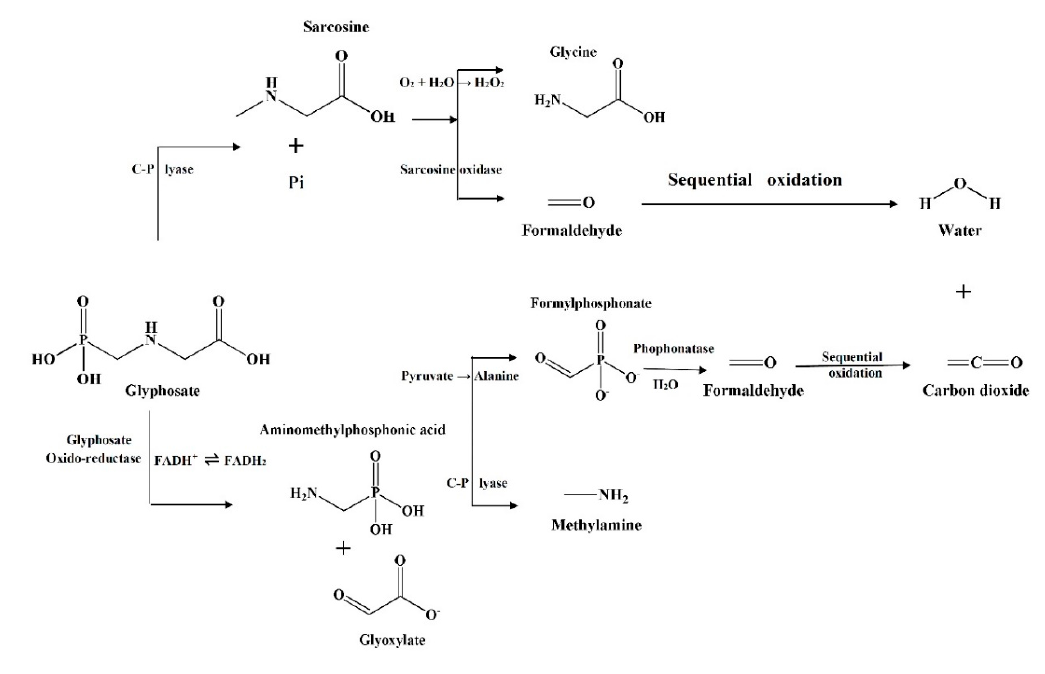
Figure 4. Enzyme mediated biodegradation of glyphosate.